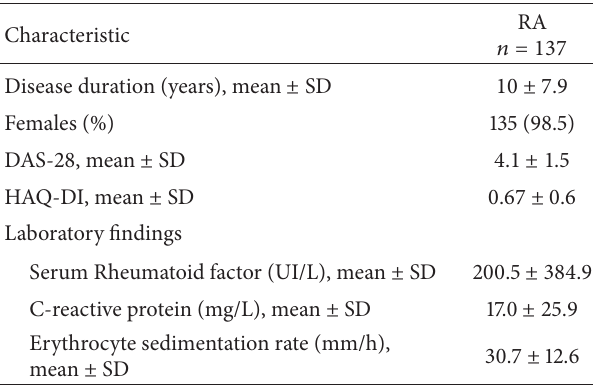
Table 2: Clinical and laboratory characteristics of patients with